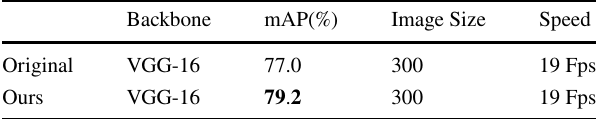
Table 2 The comparison of the original network with ours, for detect- ing objects and over the VOC